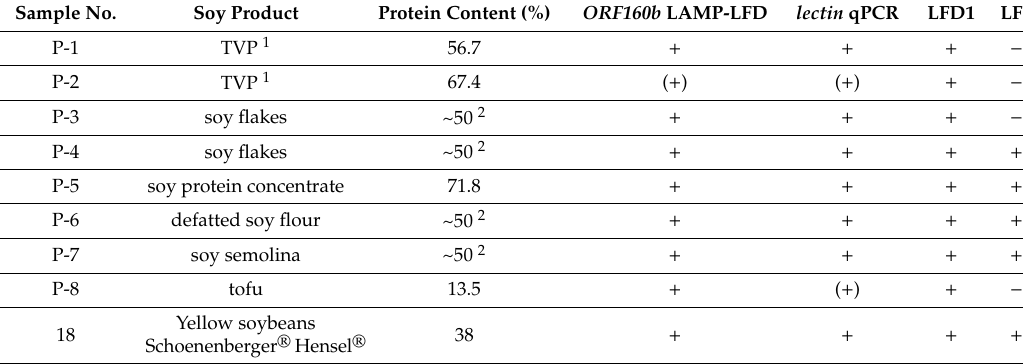
Table 2. Detection of processed soy products analyzed at 1:10 4 dilution using loop-mediated isothermal amplification (LAMP)-lateral flow dipstick (LFD), quantitative real-time PCR (qPCR) and two commercial LFD tests. ( + : all replicates positive; − : all replicates negative; ( + ): LAMP / qPCR: not all replicates positive or